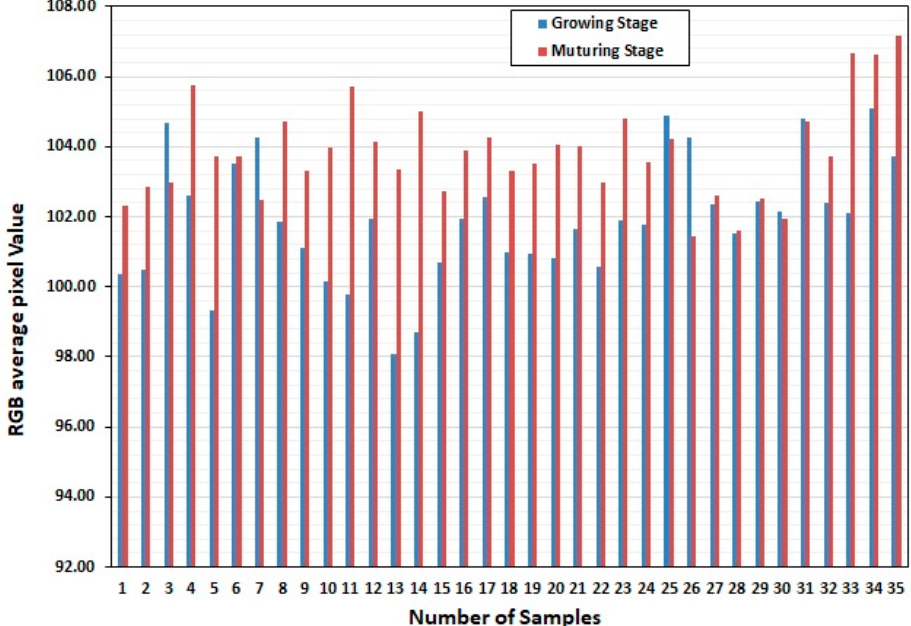
Figure 4. Distribution interval of pixel points in different stages in the G channel.